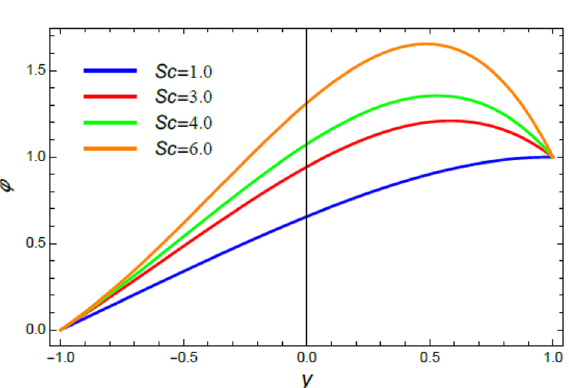
Figure 10. The nano-particles profile φ for various amounts of the Schmidt numeral Sc .